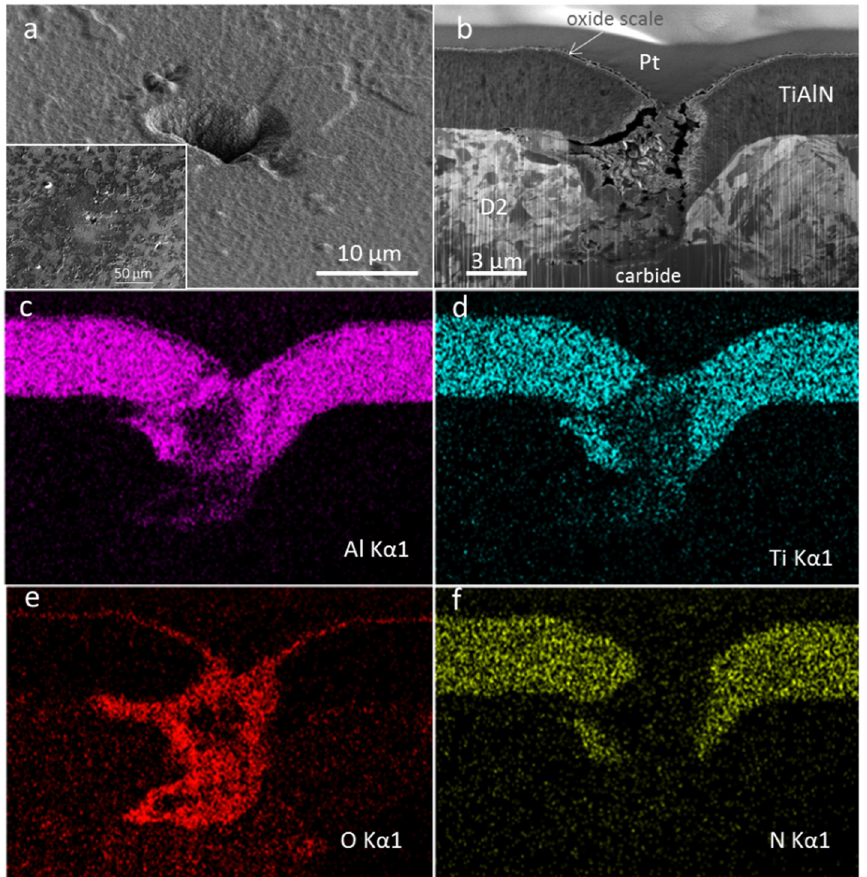
Figure 9. SEM images of pinhole in sputter-deposited TiAlN hard coating oxidized at 850 °C for 15 min: ( a ) SEM images at high and low (inset) magnification; ( b ) SEM image of the FIB cross-section of the same defect, and ( c – f ) corresponding elemental maps.